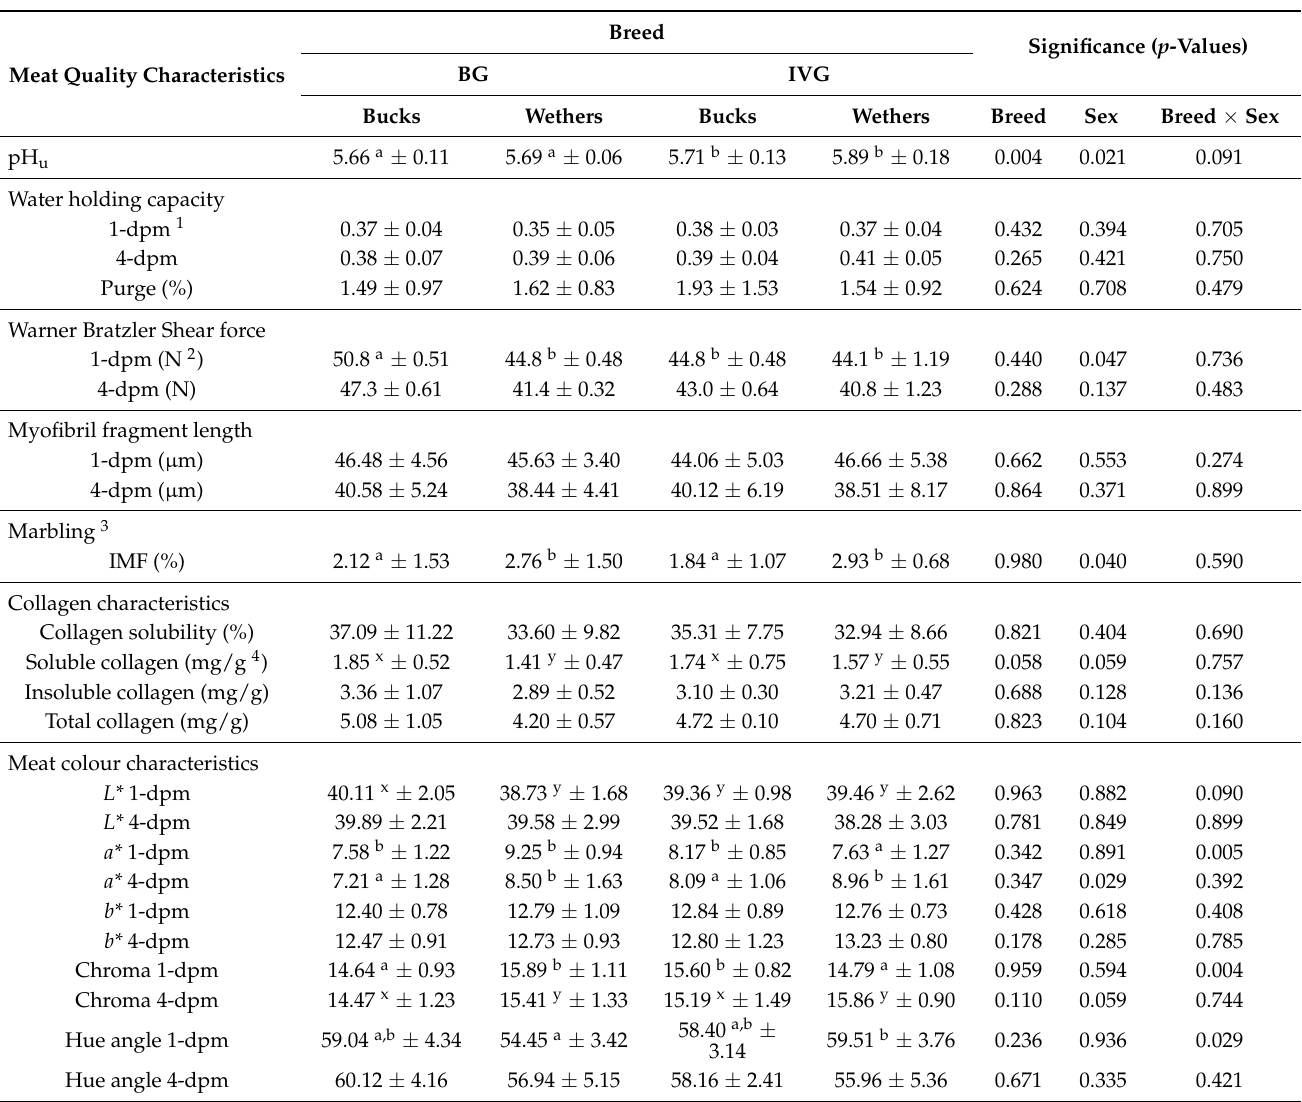
Table 7. Least square means and standard error of means for meat tenderness, meat colour and related physiological characteristics of buck and wether Boer Goats (BG) and Indigenous Veld Goats (IVG) of Semitendinosus (ST)